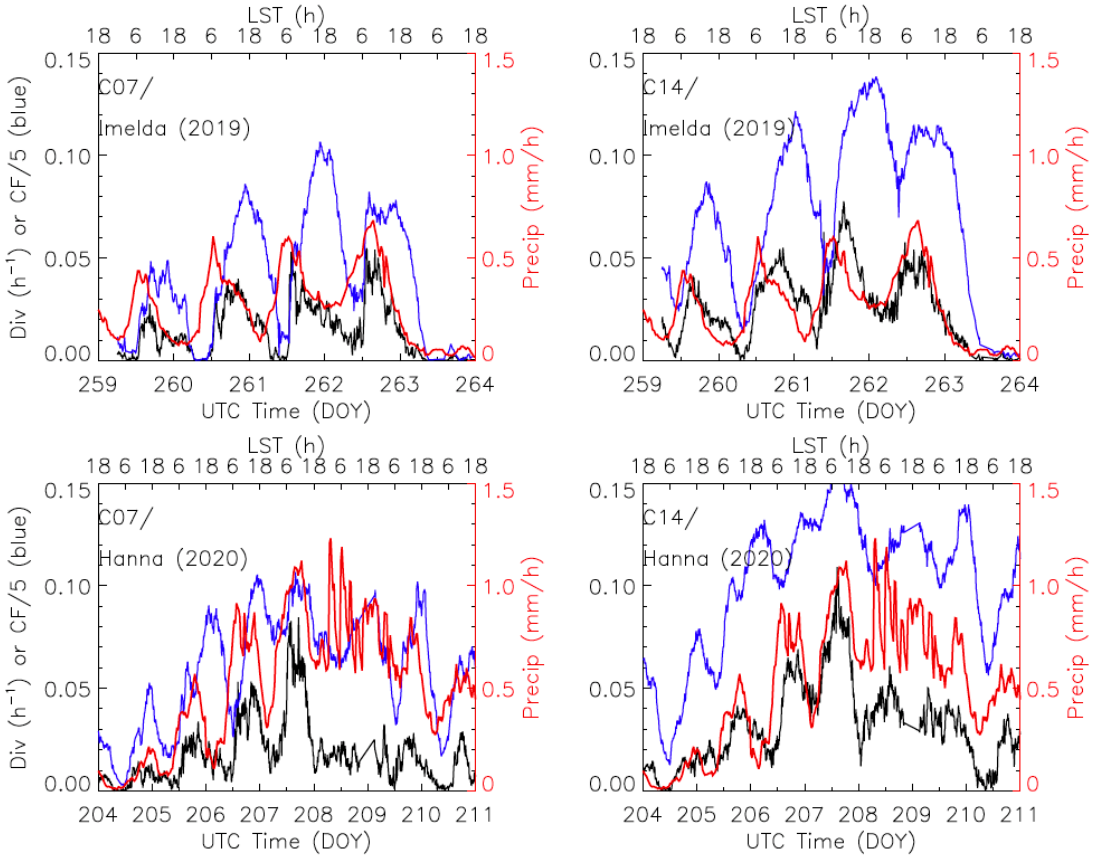
Figure 17. Time series of area-averaged cloud top divergence (black), precipitation (red) and high-cloud fraction (blue) for Imelda (2019) and Hanna (2020). The area-averaged divergences and high-cloud fraction from B07 ( left ) and B14 ( right ) are obtained from the measurements with cloud top heights > 10 km in the box area (as indicated in Figure 16). The cloud fraction is divided by 5 to plot on the divergence scale. The divergence value is normalized by the total number of observations available in the domain, to reflect an area mean of divergence strength (LST = local solar time).